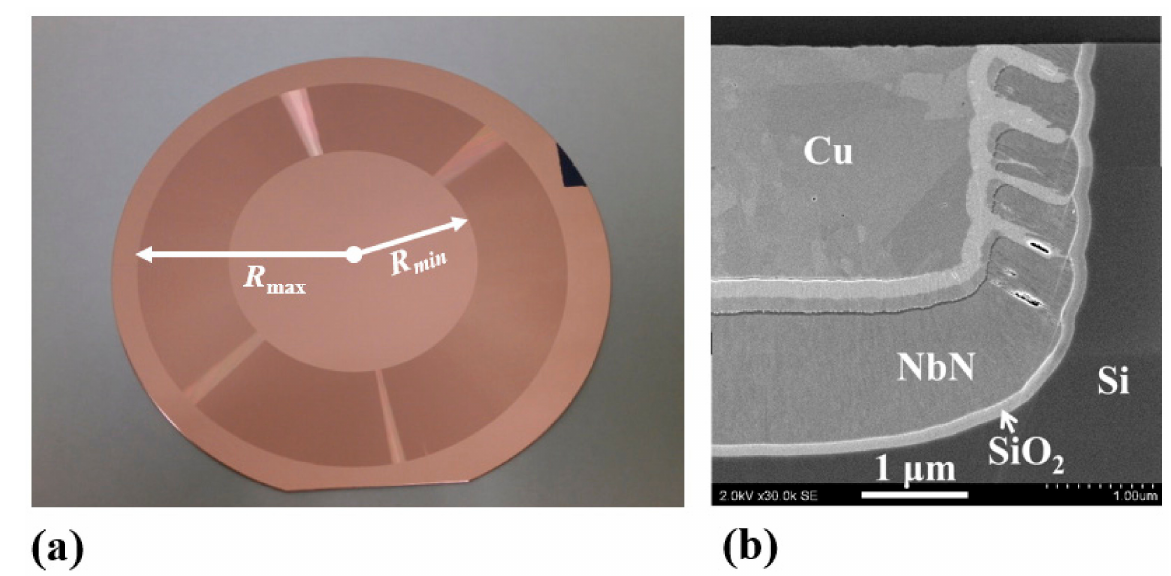
Figure 3. ( a ) A 101.6 mm Si wafer coil after the electrolytic plating of Cu corresponding to Figure 2d. R max is the radius of the outer trench wall of the outermost trench and R min is the radius of the inner trench wall of the innermost trench. ( b ) Cross-sectional SEM photograph of a half of the trench with an NbN sputter-deposited layer and electrolytically plated Cu after CMP, corresponding to Figure